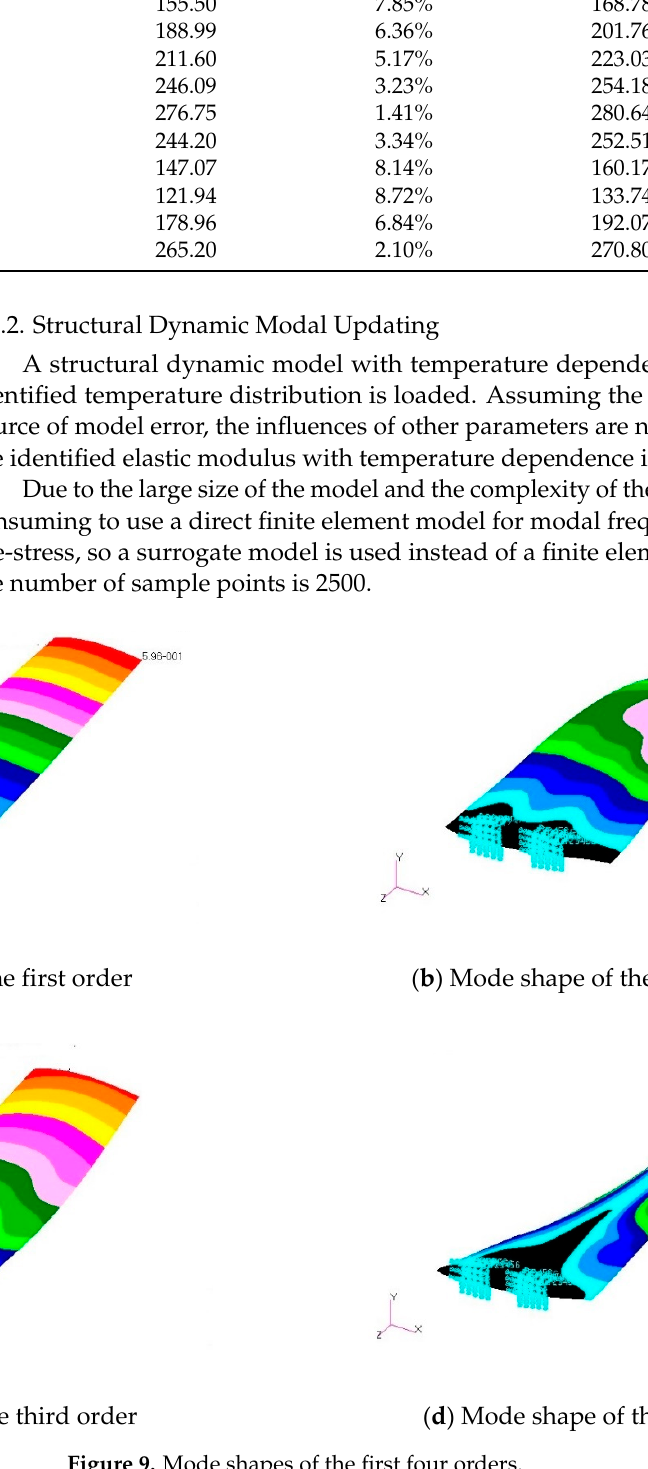
Figure 9. Mode shapes of the first four orders.